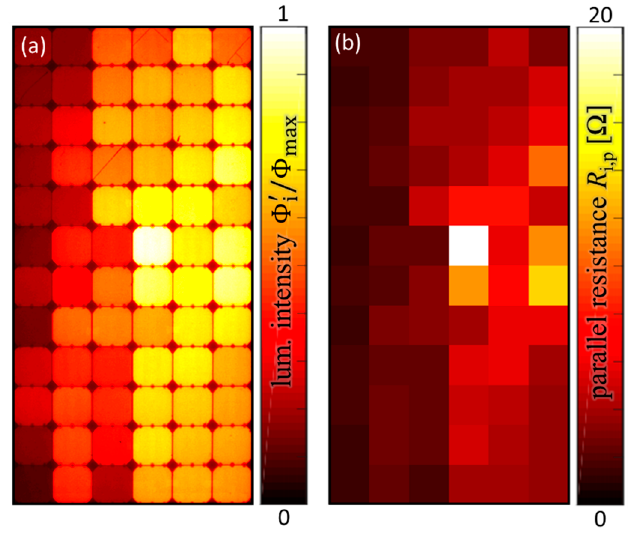
Figure 9. False color EL image of a PID affected monocrystalline silicon photovoltaic module with back-contact solar cells at ( a ) supplied current of 7% I sc with 300 s exposure time and ( b ) calculated parallel resistance map based on Equations (9) and (10).